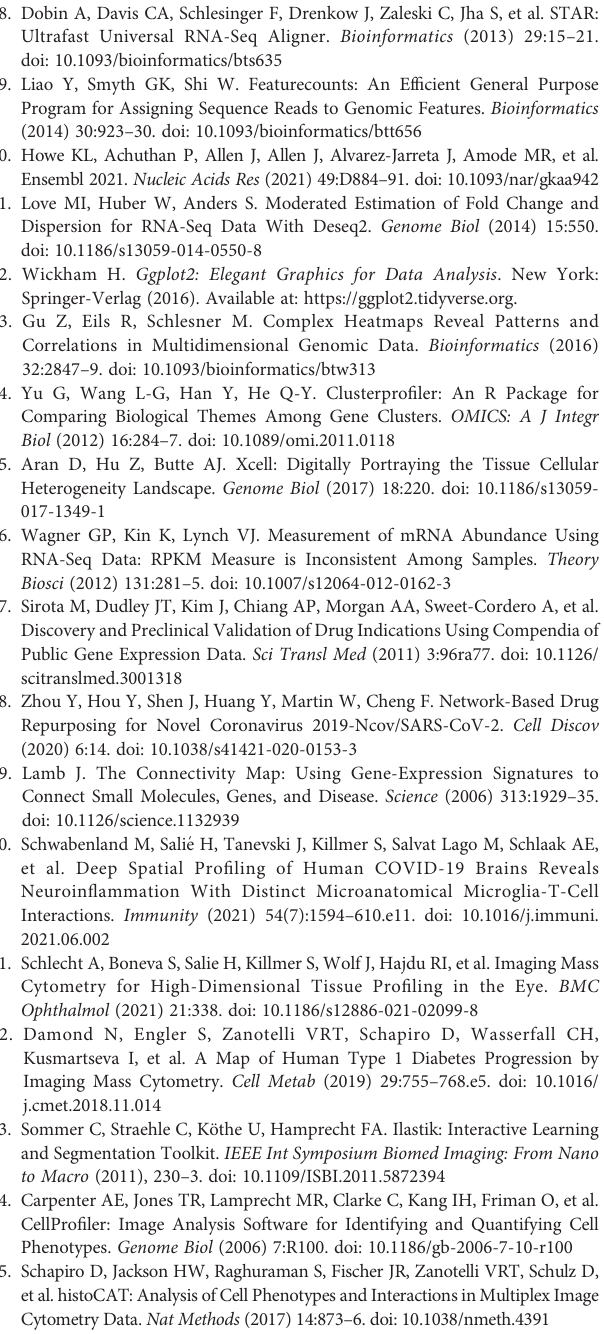
Supplementary Figure 2 | Negative and auto fl uorescence controls for immunohistochemistry. (A) Negative controls, omitting the primary antibodies, for CD206 (Cluster of Differentiation 206), FN1 (Fibronectin) and SPARC (secreted protein acidic and rich in cysteine) immunohistochemical stainings (shown in Figures 2I and 3E ) in retinal neovascularization (RNV) and internal limiting membrane (ILM) tissue samples. DAR 568, donkey anti-goat 568. DAM 488, donkey anti-mouse Alexa Fluor 488. DAR Cy5, donkey anti-rabbit Cy5. (B) Auto fl uorescence controls for CD206, FN1 and SPARC immunohistochemical stainings in RNV and ILM (shown in Figures 2I and 3E ).